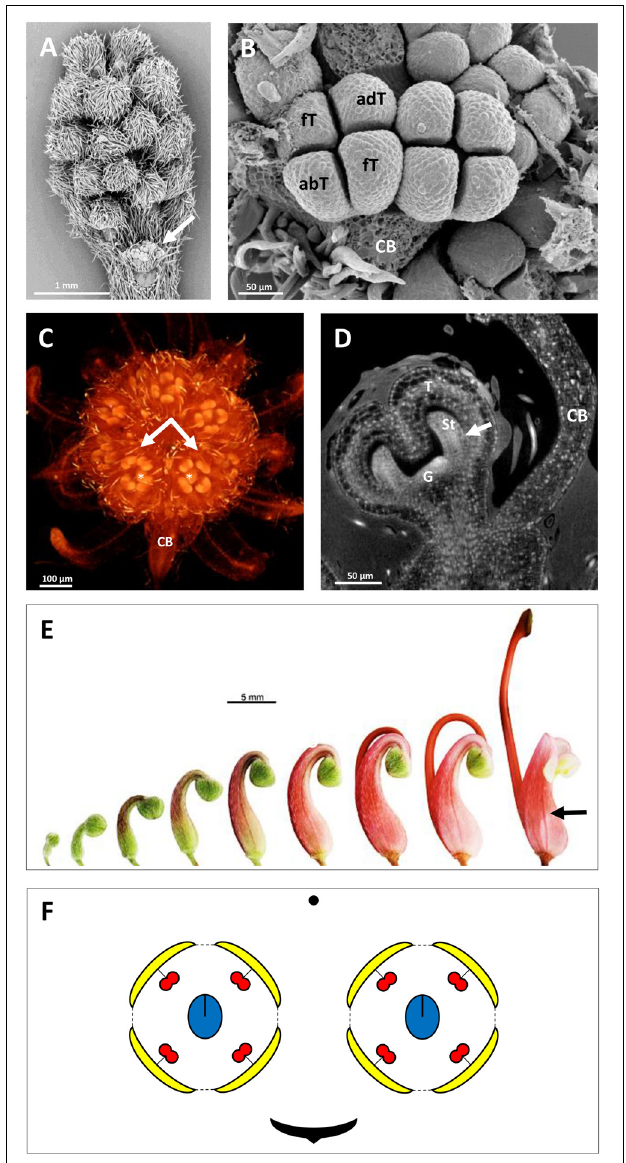
FIGURE 2 | Inflorescence and flower pair development in Grevillea juniperina ( A,B : SEM; C,D : CT-scans; E : stereomicroscope). (A) Whole inflorescence, composed of a first order axis bearing secondary order axes each surrounded by a hairy subtending bract. Each secondary axis bears pairs of flowers (conflorescences). The arrow points to one secondary order axis (subtending bract removed). (B) Flower pair, with common subtending bract (CB) removed, showing incomplete valvate aestivation of the tepals (fT, frontal tepal; adT, adaxial tepal = dorsal tepal; abT, abaxial Tepal = ventral tepal). (C) Top view of a second order axis of inflorescence, showing a flower pair from top view (arrows) with all organs initiated; the flower is made zygomorphic by the non-central position of the gynoecium (asterisks). (D) Virtual longitudinal section of a young flower bud showing the monosymmetrical gynoecium primodium (G); the arrow points to the fusion between a stamen and a tepal. (E) Floral developmental sequence, from the first stage at which zygomorphy becomes conspicuous (left) to anthetic flower. The arrow points to the strongly zygomorphic ovary visible through the perianth. (F) Floral diagram of a flower pair of Grevillea juniperina showing the orientation of each flower relatively to the common